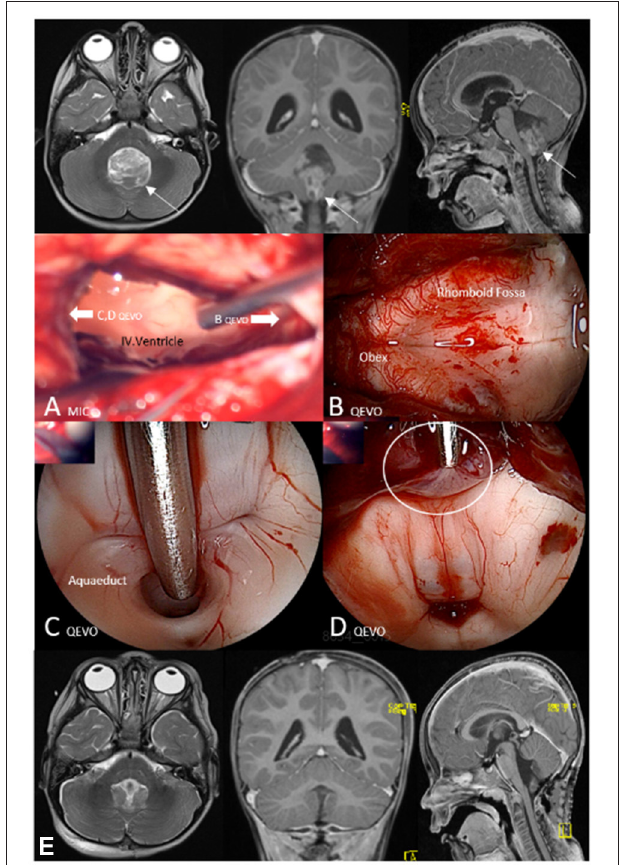
FIGURE 4 | Illustrative case 3—area 3, QEVO ® categories (D, E) . Patient #2, anaplastic ependymoma WHO III, median suboccipital approach. Upper row, Preoperative magnetic resonance image (MRI) in axial plane (T2), coronal plane, and sagittal plane (T1 with contrast medium); (A) MIC(roscopic), View at the IV.ventricle after tumor resection; the white arrows indicate the visual trajectories of the micro-inspection tool QEVO ® (B–D) ; (B) QEVO, Inspection of the dorsal horn and related structures; (C) QEVO, Endoscopic view at the aquaeductus cerebri; (D) QEVO, Tumor remnant at the roof of the ventricle (white circle); (E) Lower row, Postoperative MRI in axial plane (T2), coronal plane, and sagittal plane (T1 with contrast medium). White arrows indicate the tumor within the IV ventricle on the preoperative MRI; the white circle indicates a tumor remnant at the roof of the ventricle. evaluated to be tumor-free, and adjuvant treatment was planned accordingly. The further clinical course was uneventful, no new deficits occurred, and wound healing was unaffected. Figure 5 . Brief case description and surgical strategy: A 60-year-old woman had developed headache, nausea, and vomiting. MRI showed a huge infratentorial mass within the lower cerebellum close to the foramen magnum. The patient underwent median suboccipital craniotomy and opening of the foramen magnum in prone position. The lesion was analyzed as dermoid cyst and completely removed microscopically ( Figure 5A ). To rule out any relevant bleeding or undetected satellites, the QEVO R (cid:13) tool was used to provide an overview of the medullary parts below the foramen magnum ( Figure 5B ) and to inspect the lateral parts of the cranio-cervical